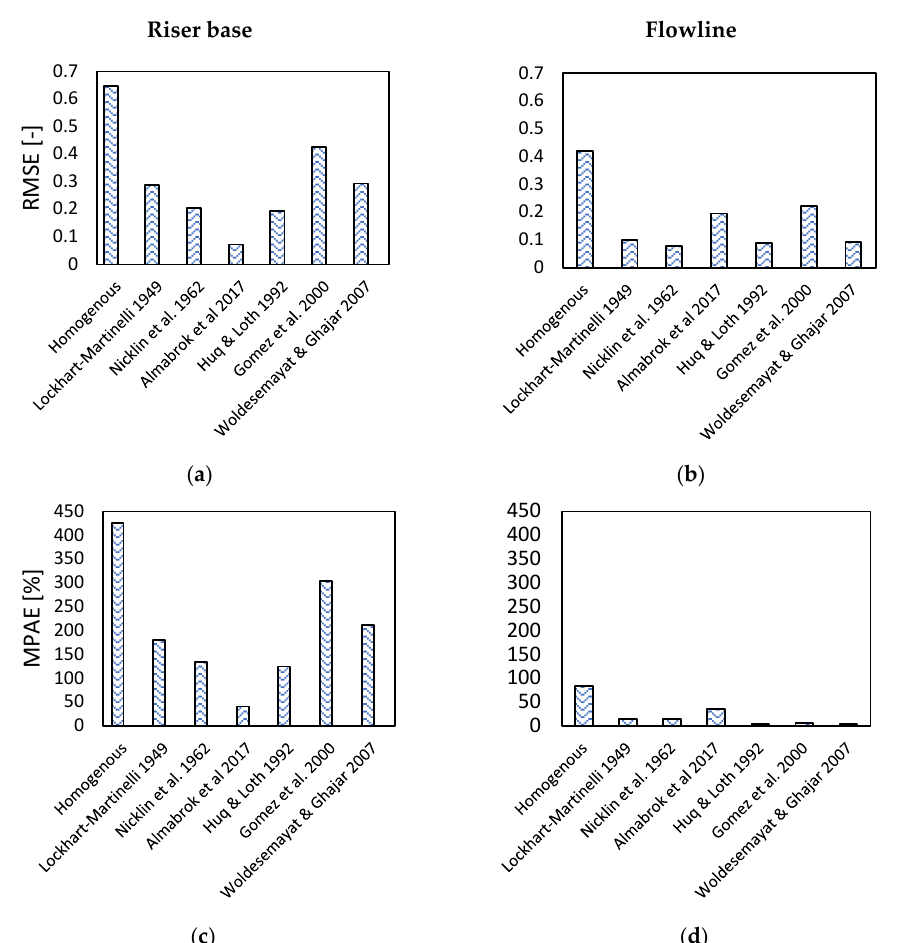
Figure 9. Mean square and mean percentage absolute errors for the various model predictions compared with the current experimental liquid holdups for the riser base and flow line injection methods [13,14,16,17,20,34] ( a ) RMSE for riser base ( b ) RMSE for flow line ( c ) MPAE for riser base ( d ) MPAE for flow line.